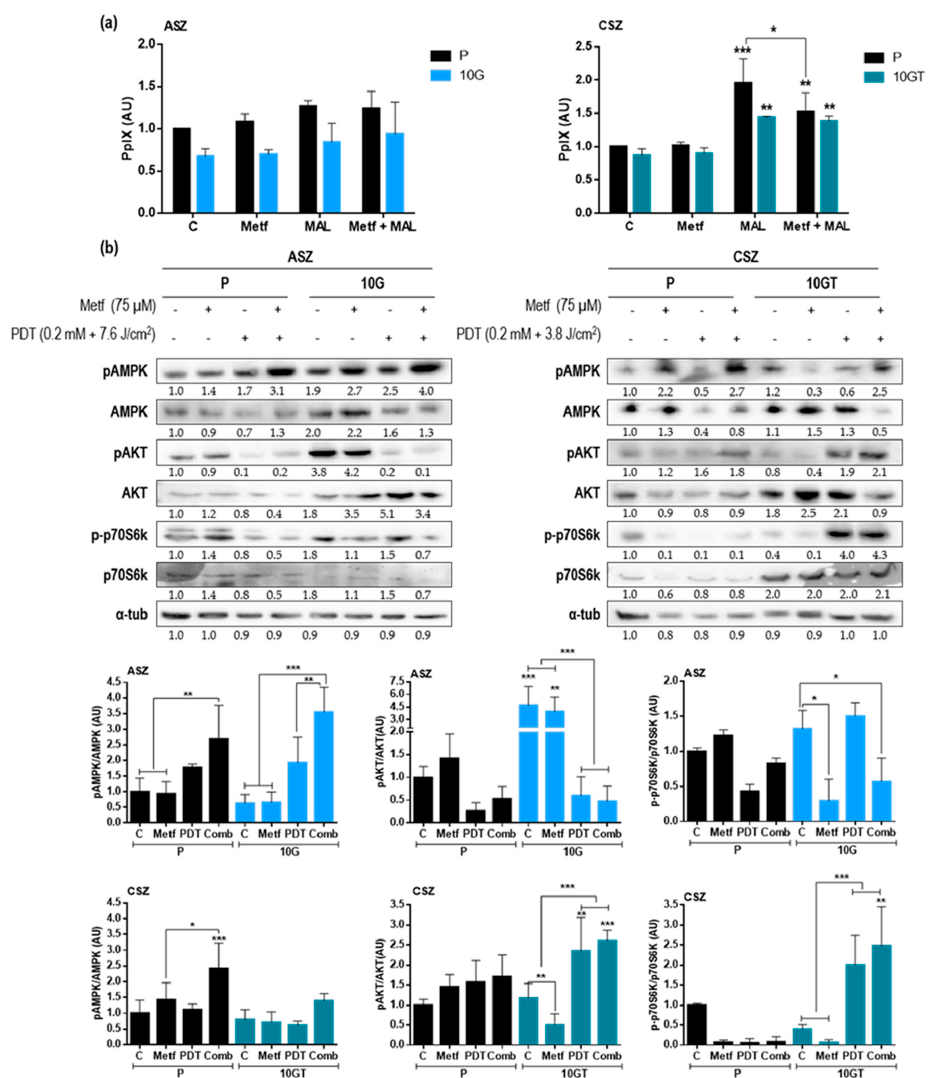
Figure 5. Effect of the combined treatment of Metf and MAL-PDT on BCC cell lines: ( a ) PpIX production was evaluated by flow cytometry after incubation with Metf (24 h, 75 µM), MAL (5 h, 0.2 mM), and Metf and MAL (24 h followed by 5 h, respectively). ( b ) Expression by western blot of AMP-activated protein kinase (AMPK)-mammalian target of rapamycin (mTOR) pathway components: pAMPK, AMPK, pAKT, AKT, p-p70S6K and p70S6K after treatments (Metf, MAL-PDT, and Metf plus MAL-PDT). A representative experiment of each marker is shown, and pAMPK/AMPK, pAKT/AKT, and p-p70S6K/p70S6K densitometry graphics of both P and resistant populations of ASZ and CSZ cells are shown. Alfa tubulin was used as loading control. For each cell population, 4 conditions were evaluated: control; 24 h after 75µM Metf; 24 h after PDT treatment (5 h incubation with MAL and 7.6 J/cm 2 in ASZ and 3.8 J/cm 2 in CSZ cells); and combination of Metf and MAL-PDT. Values were represented as mean ± SD (* p < 0.05; ** p < 0.01; *** p < 0.001).